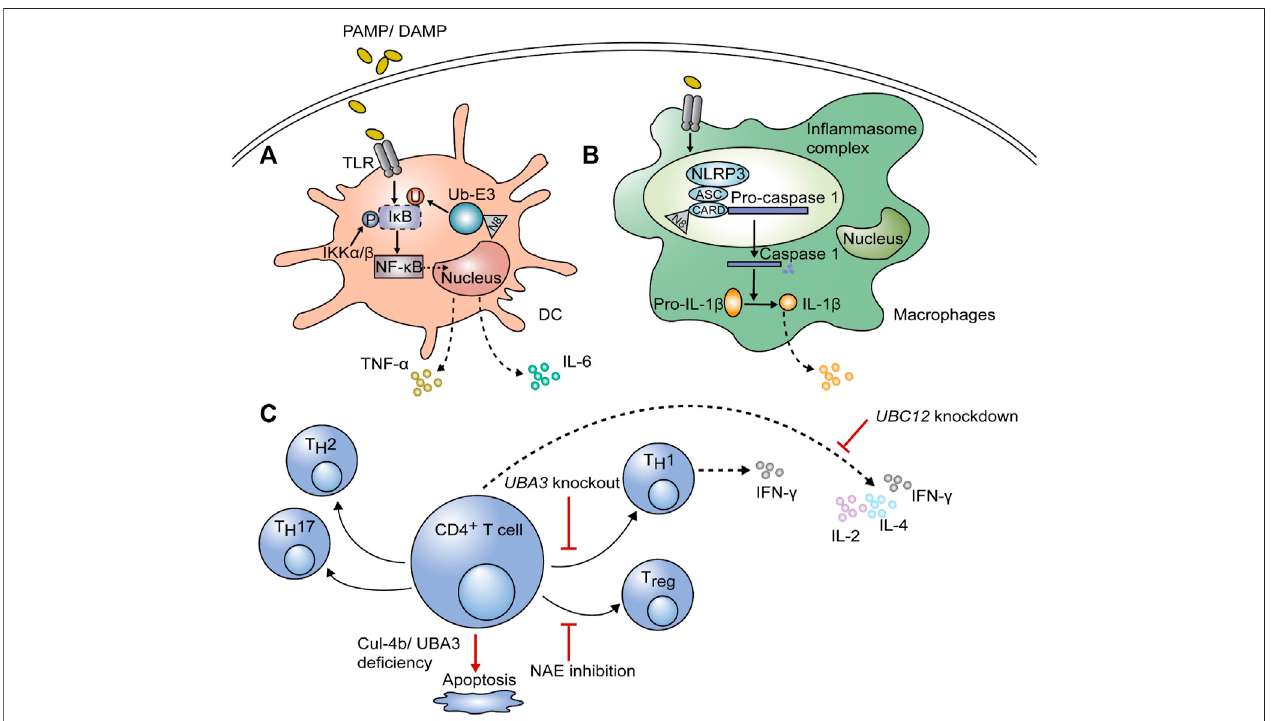
FIGURE2| Thefunctionofneddylationonimmunecells.Afterstimulationwithpathogen-associatedmolecularpatternsordamage-associatedmolecularpatterns (PAMPs or DAMPs), neddylation is required to induce proin fl ammatory cytokines, including interleukin-6 (IL-6) and tumor necrosis factor- α (TNF- α ), in dendritic cells (DCs) and macrophages. (A) After ubiquitination and degradation of inhibitor κ B (I κ B), nuclear factor (NF)- κ B translocates into the nucleus and initiates gene expression; this process is dependent on the neddylation of ubiquitin E3 ligase. (B) The NLR family pyrin domain containing 3 (NLRP3) in the in fl ammasome complex of macrophages can be neddylated at the caspase recruitment domain (CARD), leading to self-cleavage of pro-caspase-1 and maturation of IL-1 β , thus affecting in fl ammation. (C) Foradaptiveimmunecells,inhibitionofneddylationbyknockdownof UBC12 blockscytokinesecretionbyCD4 + Tcells,includingthatofIL-2,IL-4,and IFN- γ . Knockout of UBA3 can downregulate interferon (IFN)- γ -producing T H 1 cells and even result in apoptosis. NEDD8-activating enzyme (NAE) inhibition can regulate the polarization of CD4 + T cells with lower T reg differentiation and a shift towards the T H 1 phenotype. The de fi ciency of Cul-4b also has negative effects on CD4 + T cell